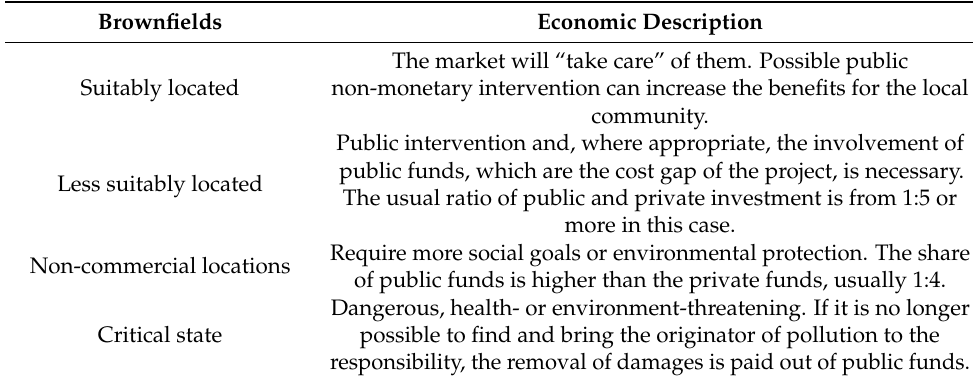
Table 1. Types of brownfields from an economic point of view [36,37].